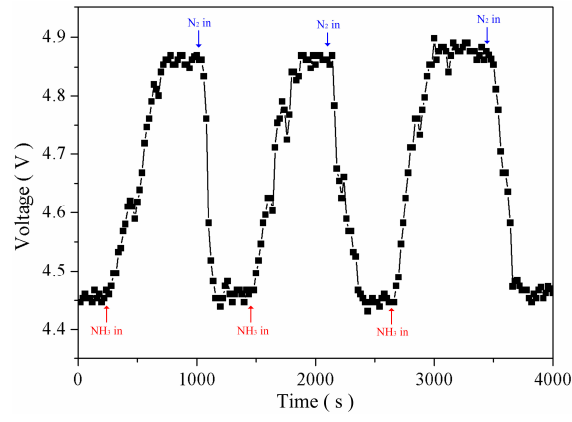
Figure 9. Dynamic characteristic of the NH 3 sensor for analyzing the response time and recovery property.